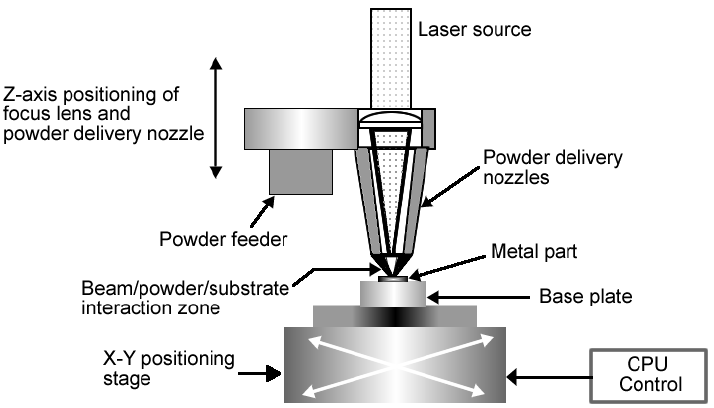
Figure 8. Schematic representation of LENS